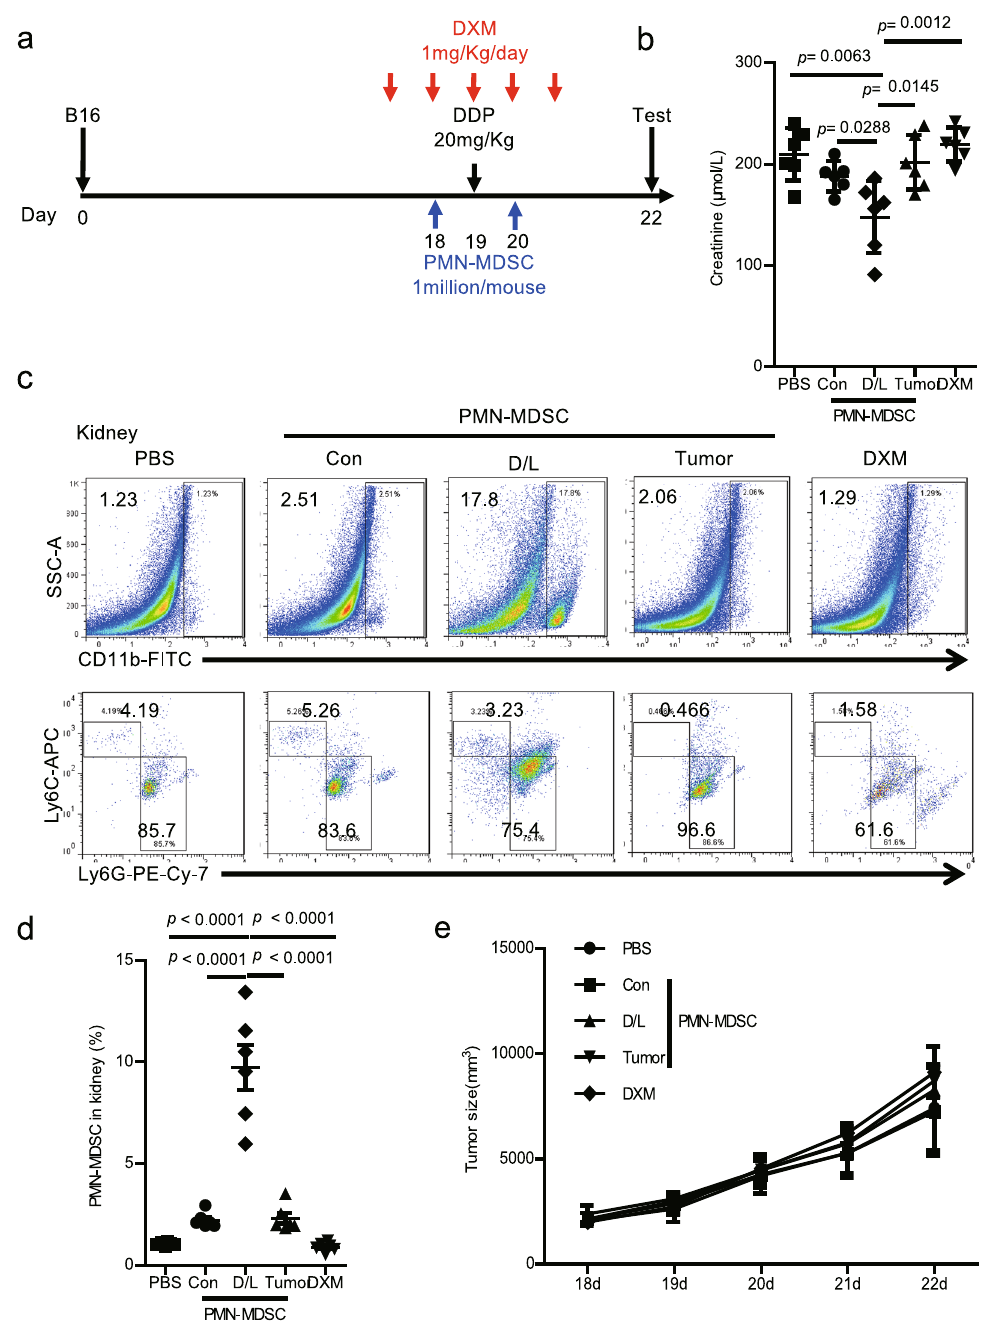
Fig. 5 Transfer of DXM/lactoferrin PMN-MDSCs relieved cisplatin-induced AKI without promoting tumor development. a Diagram of the experimental design. DDP (20 mg/Kg) was administered intratracheally to wild type (WT) mice 19 d after tumor implantation, and tested on day 22. Cells (1 × 10 6 ) of Con PMN-MDSC, DXM/lactoferrin (D/L) PMN-MDSC, tumor PMN-MDSC, or vehicle control (PBS) was administered i.v. on days 18 and 20. DXM was administered at 1 mg/kg/day from day 17 through 21 in the indicated group. b Serum creatinine level in each group. c Typical example of fl ow cytometric analysis and d statistical analysis of PMN-MDSCs in the mouse kidneys. e Tumor growth ( n = 6 biologically independent animals). Error bars displayed the mean and standard